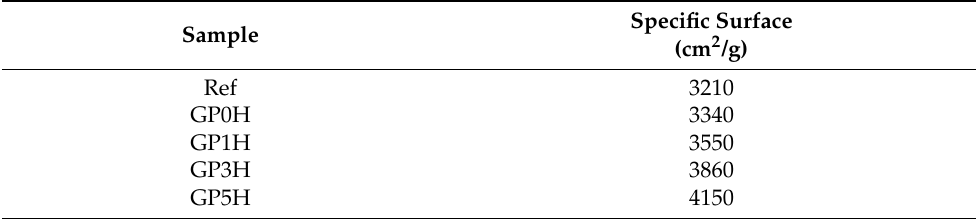
Table 4. Calculated specific surface of